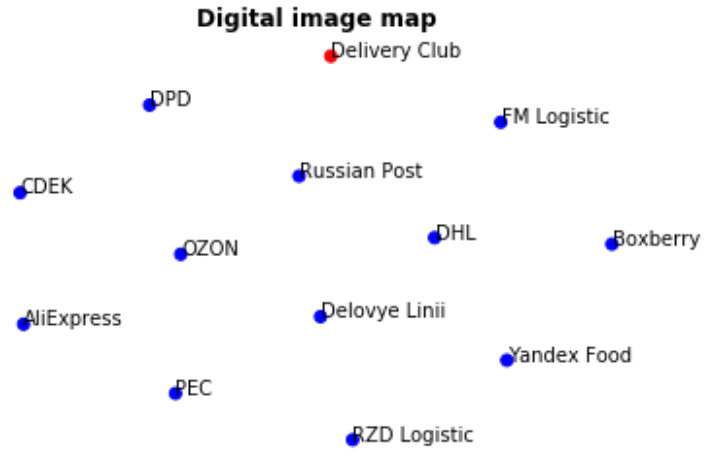
Figure 11. Digital image map.